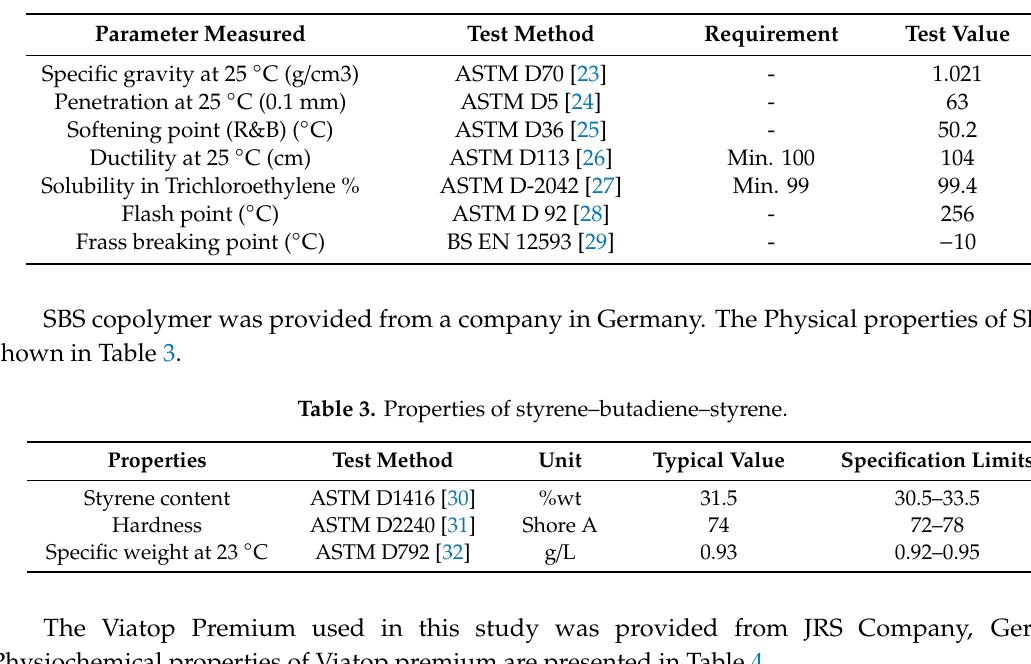
Table 2. The physical properties of asphalt cement.